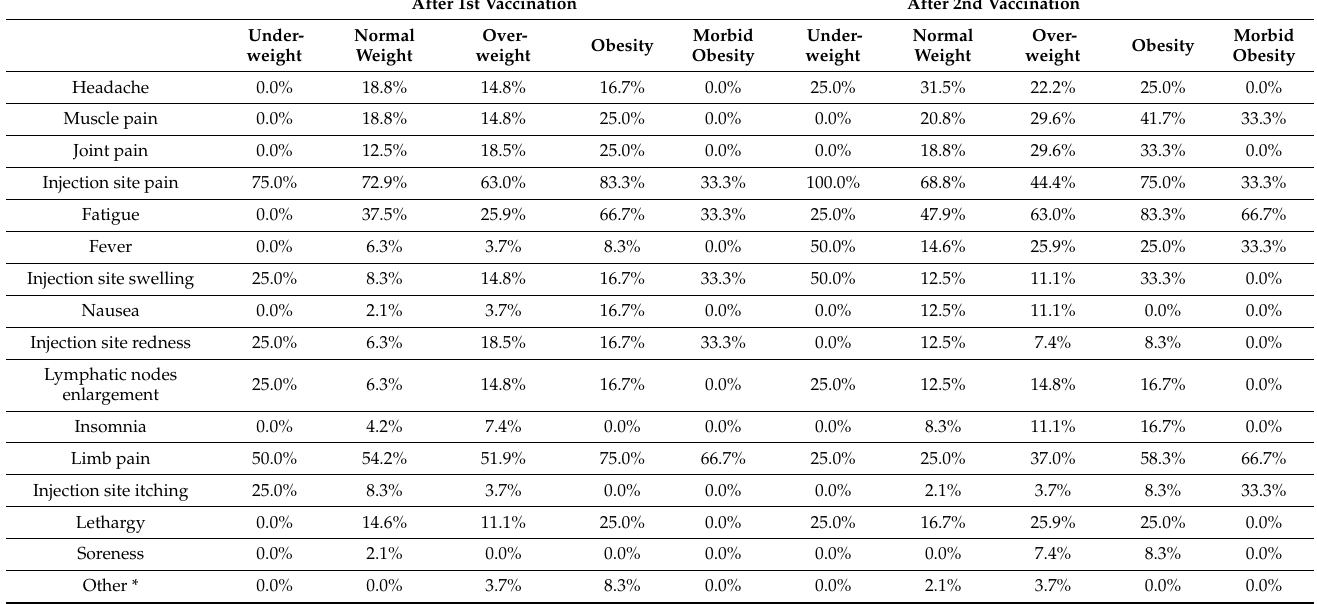
Table 5. Incidence of adverse events by body mass index (BMI) groups. * Other adverse events that respondents mentioned after first vaccination were eyelash edema, tearing, and herpes labialis; after second vaccination: pain in the lumbosacral region and hypertension. These were all